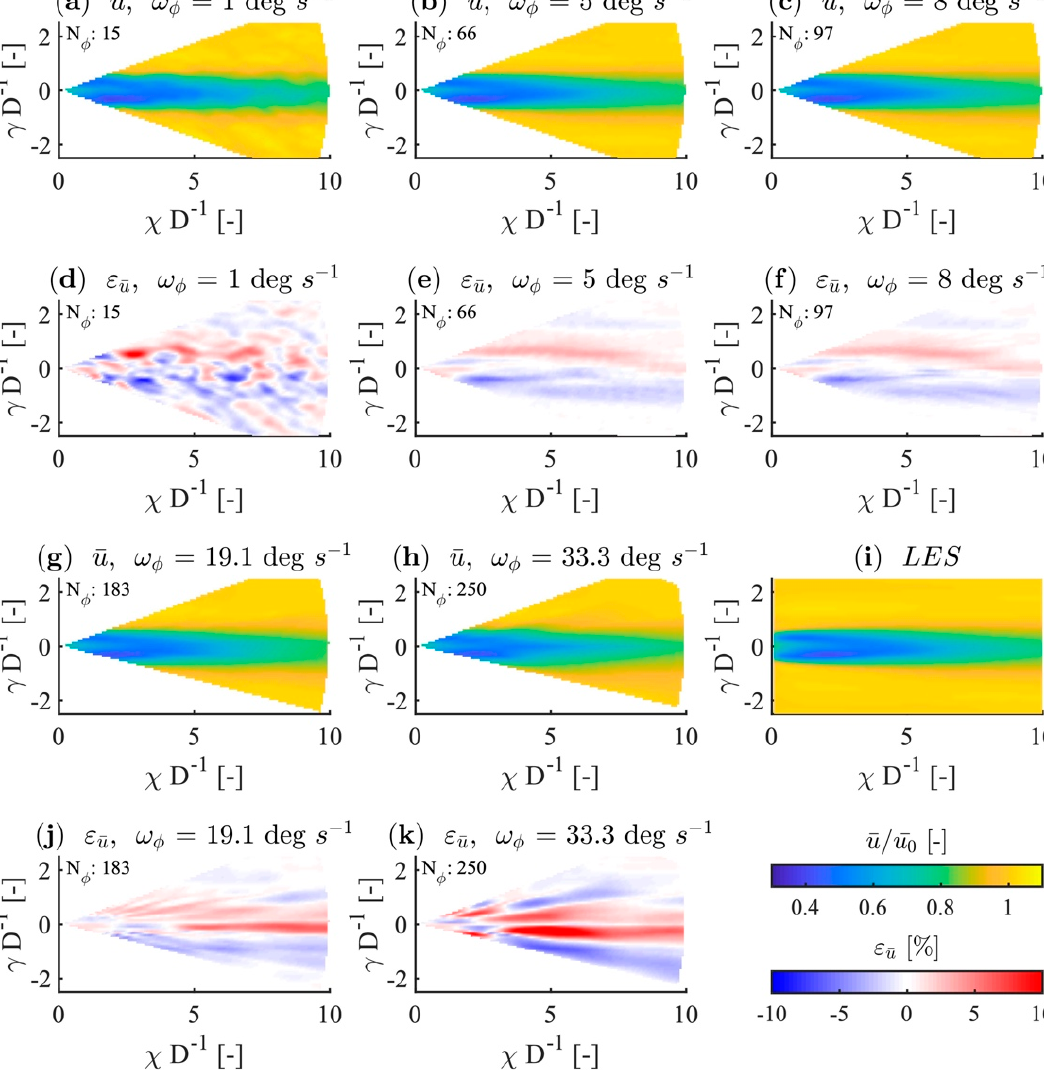
Figure 7. ( a – c , g , h ) Visualisation of the normalised 10-min averaged wind-speed component ( u ) of the original PPI data and ( d – f , j , k ) the corresponding flow deviations ( ε u ) in comparison to ( i ) the normalised 10-min averaged wind-speed component ( u ) of the LES data.